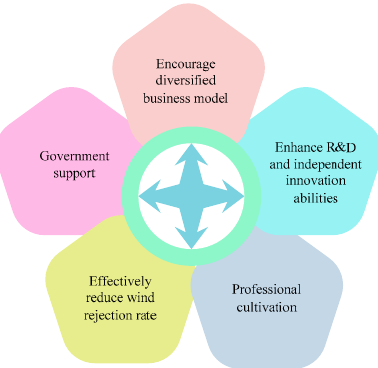
Figure 16. Framework for improving value creation and the innovation effect of the value chain.